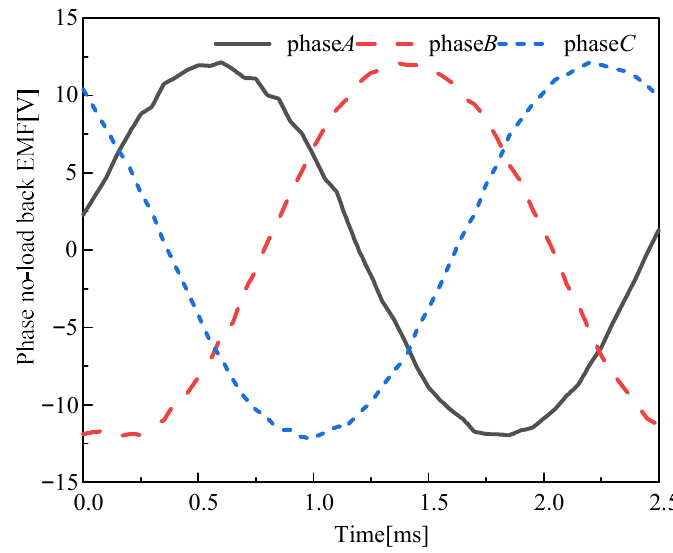
Figure 9. Three-phase load back EMF.